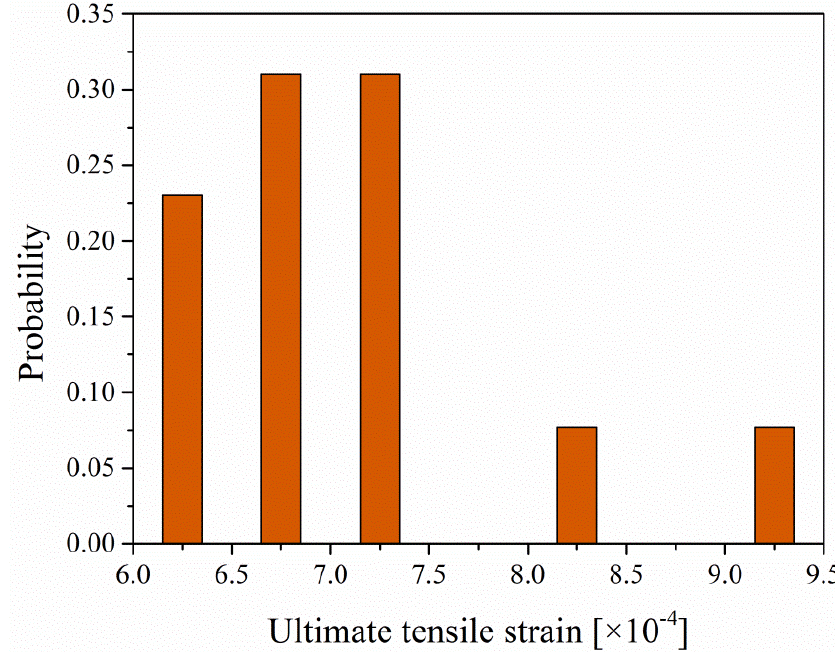
Figure 8. Statistics of the ultimate strain of EPC.